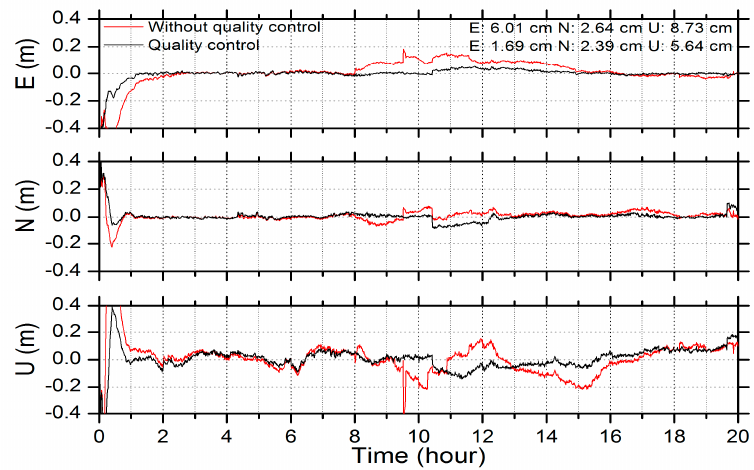
Figure 6. The positioning error of the single GPS PPP solution with quality control and without quality control at station BRST (E: east; N: north; U: upward).